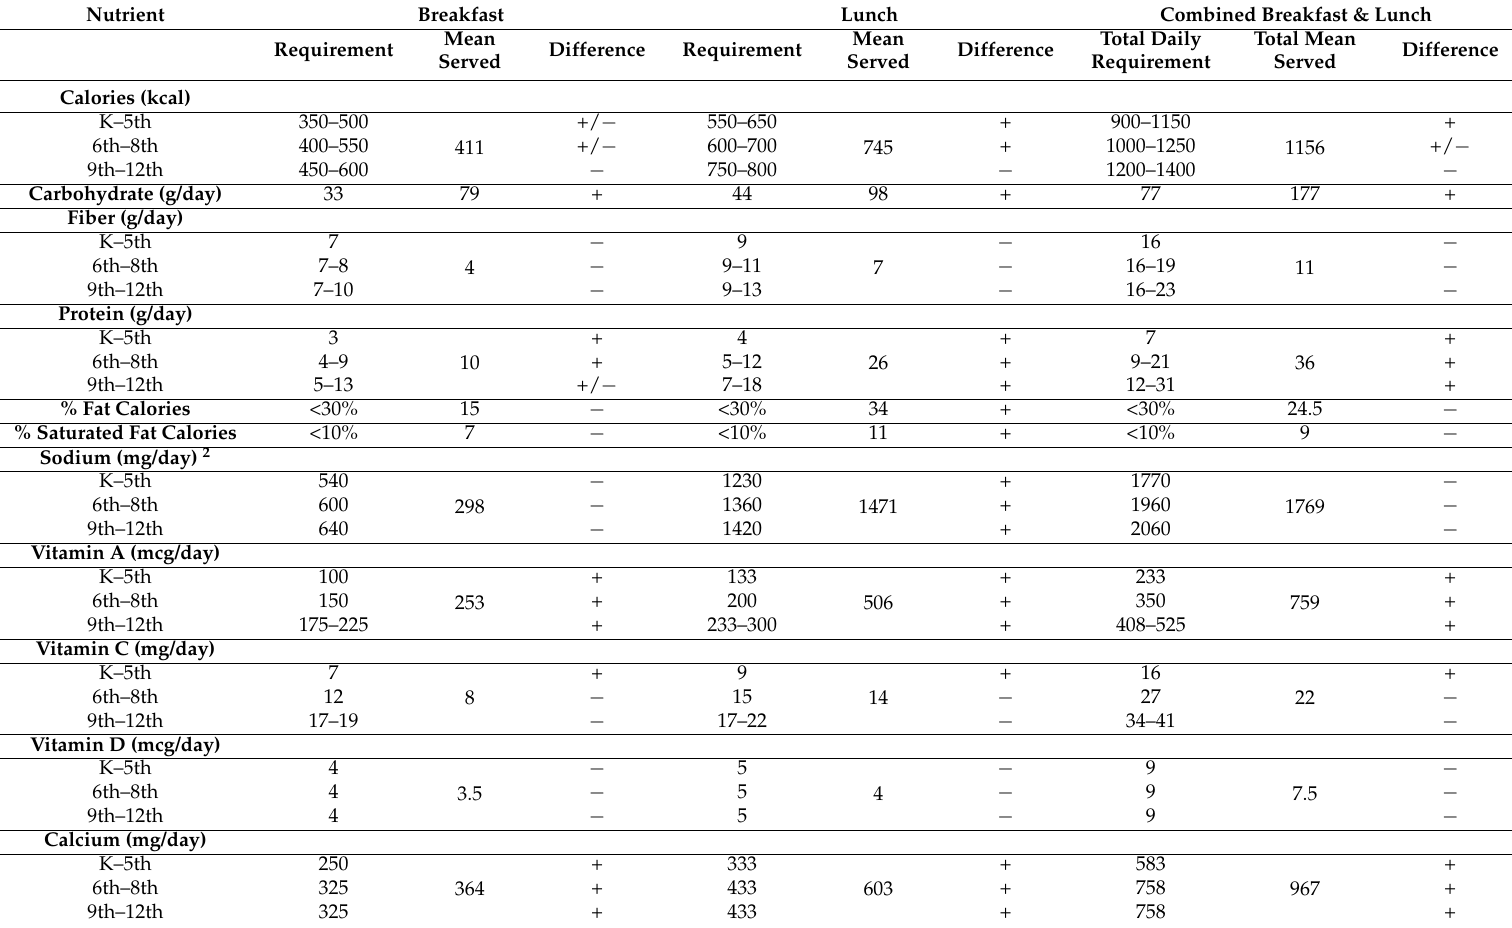
Table 6. Case Study on the Nutritional Adequacy of a Sample Summer Food Service Program (SFSP) Breakfast and Lunch Menu from July 2014 and Comparison to Requirements for National School Lunch Program (NSLP) and School Breakfast Program (SBP) 1